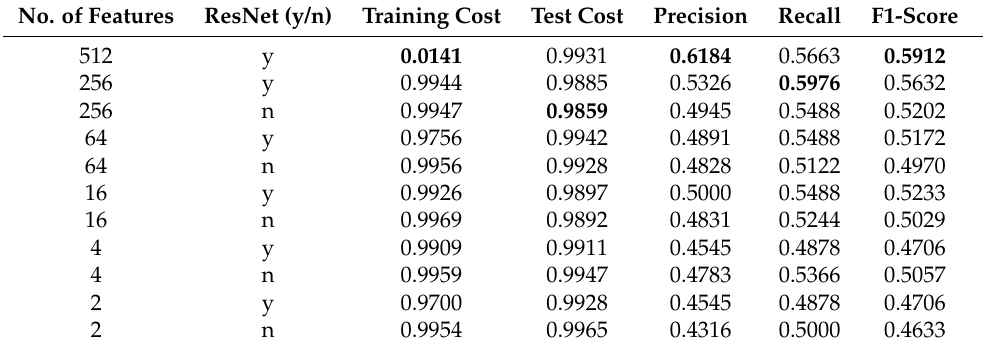
Table 1. Test set assessment outcomes for training performed on the Hymenoptera dataset’s training set. Corresponding training costs are also given. In each row, training was performed for 1500 itera- tions using the root mean squared propagation optimizer (step size of 0.01) and a batch size of 10. All values are given to four decimal places. The features in row 1 did not undergo PCA, while the features from the rest of the rows did. A random seed of ’123’ used for the train-test split in every row other than the first (the first row used the default train-test split of the Hymenoptera dataset). The same random seed of ’123’ was used for all subsequent evaluations in all rows. The best value for each column is shown in